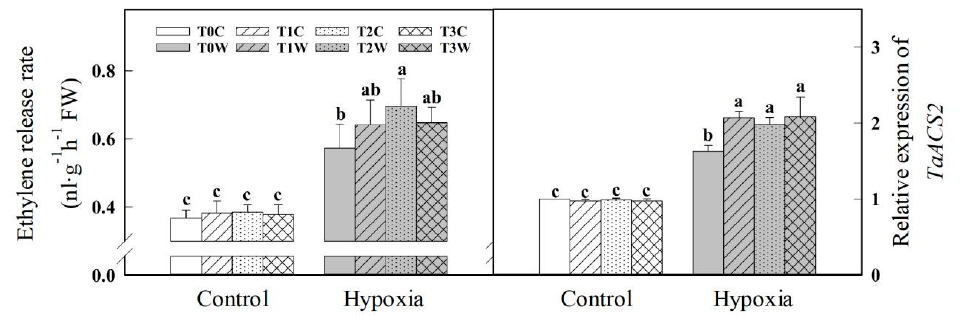
Figure 8. Effects of waterlogging priming on ethylene release rate and TaACS2 gene expression in root of offspring plants under hypoxia stress in wheat seedling. Note: TaACS2 : 1-aminocyclopropane-1-carboxylate (ACC) synthase gene. T0C, no priming + no offspring hypoxia stress; T0W, no priming + offspring hypoxia stress; T1C, one-generation priming + no offspring hypoxia stress; T1W, one-generation priming + offspring hypoxia stress; T2C, two-generation priming + no offspring hypoxia stress; T2W, two-generation priming + offspring hypoxia stress; T3C, three-generation priming + no offspring hypoxia stress; T3W, three-generation priming + offspring hypoxia stress. Data are means ± SE (n = 3). Different lowercase letters indicate the significant difference at p < 0.05 level.